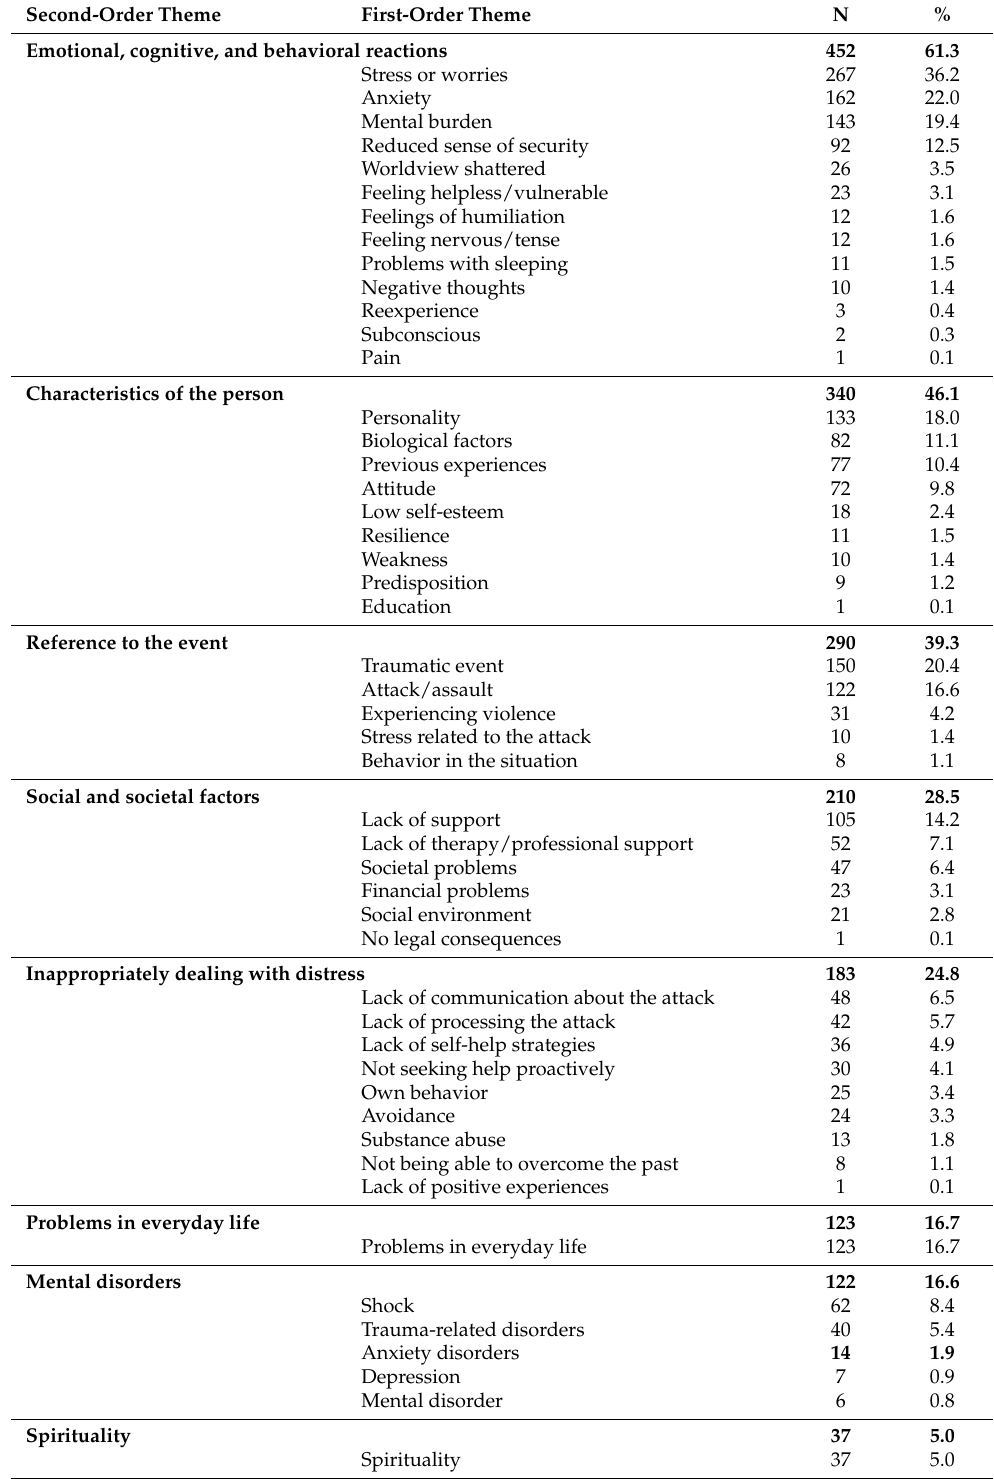
Table 2. Percentage of participants mentioning each causal belief according to the thematic analysis of responses to naming the most likely